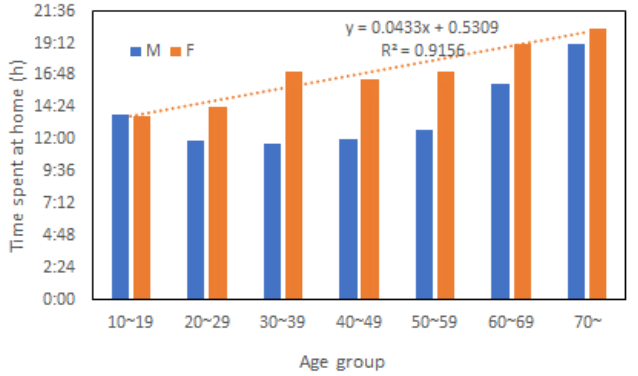
Figure 4. Relationships between age, gender, and fatality rates.